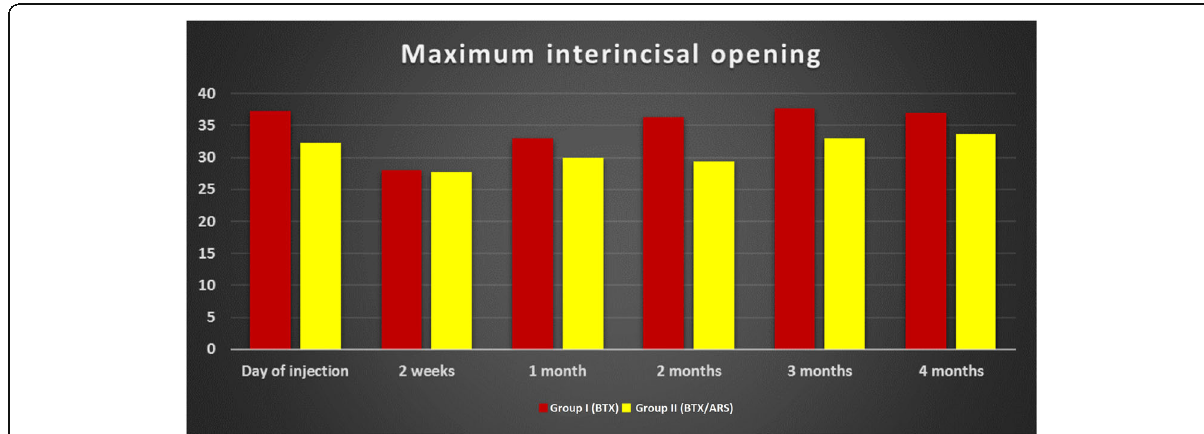
Fig. 4 Bar graph showing the maximal interincisal opening in millimetres along the study period in both